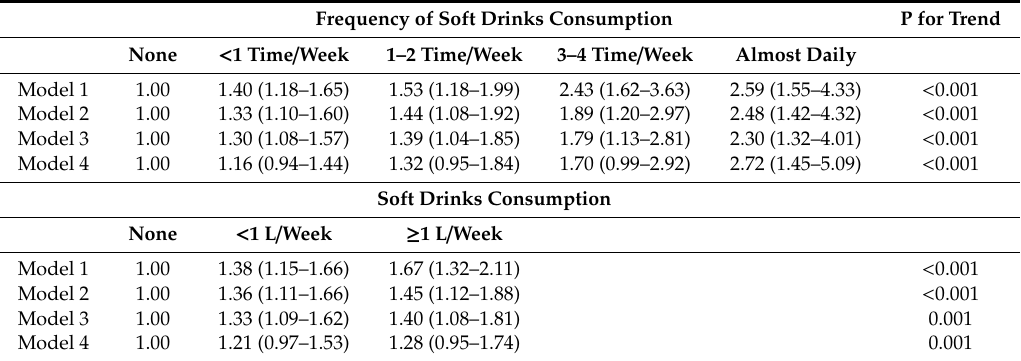
Table 2. Odds ratio (95%CI) for fracture by soft drinks consumption levels among Chinese adults attending China Health and Nutrition Survey (n =